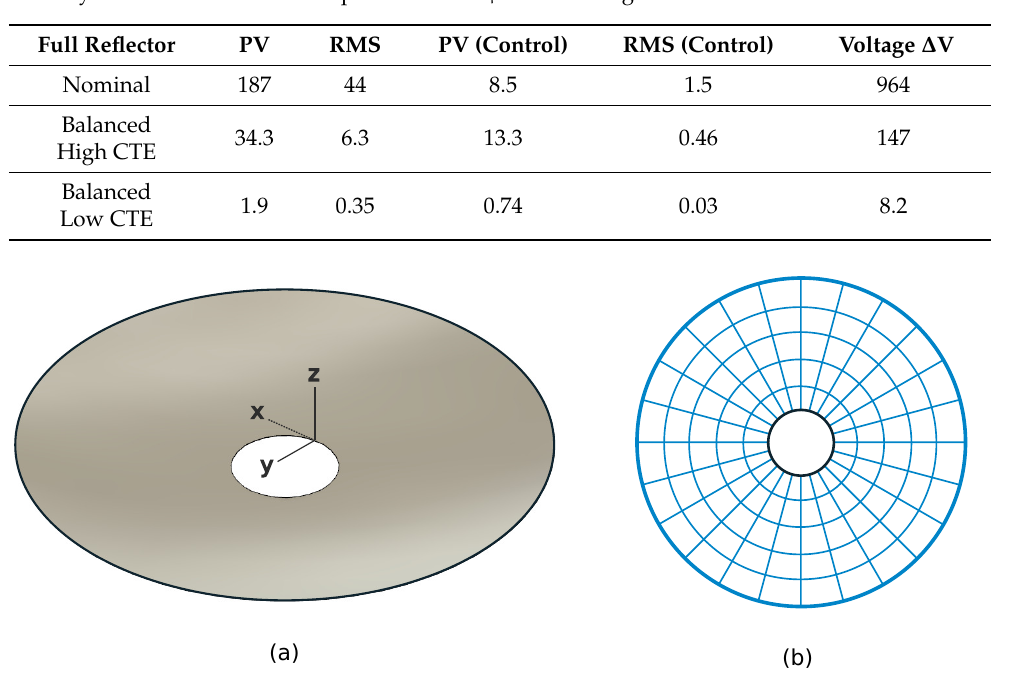
Figure 6. ( a ) Spherical reflector with D = 1 m, d = 0.2 m, R c = 4 m, supported along the local axes y and z along the inner boundary. ( b ) Layout of the 120 control electrodes.